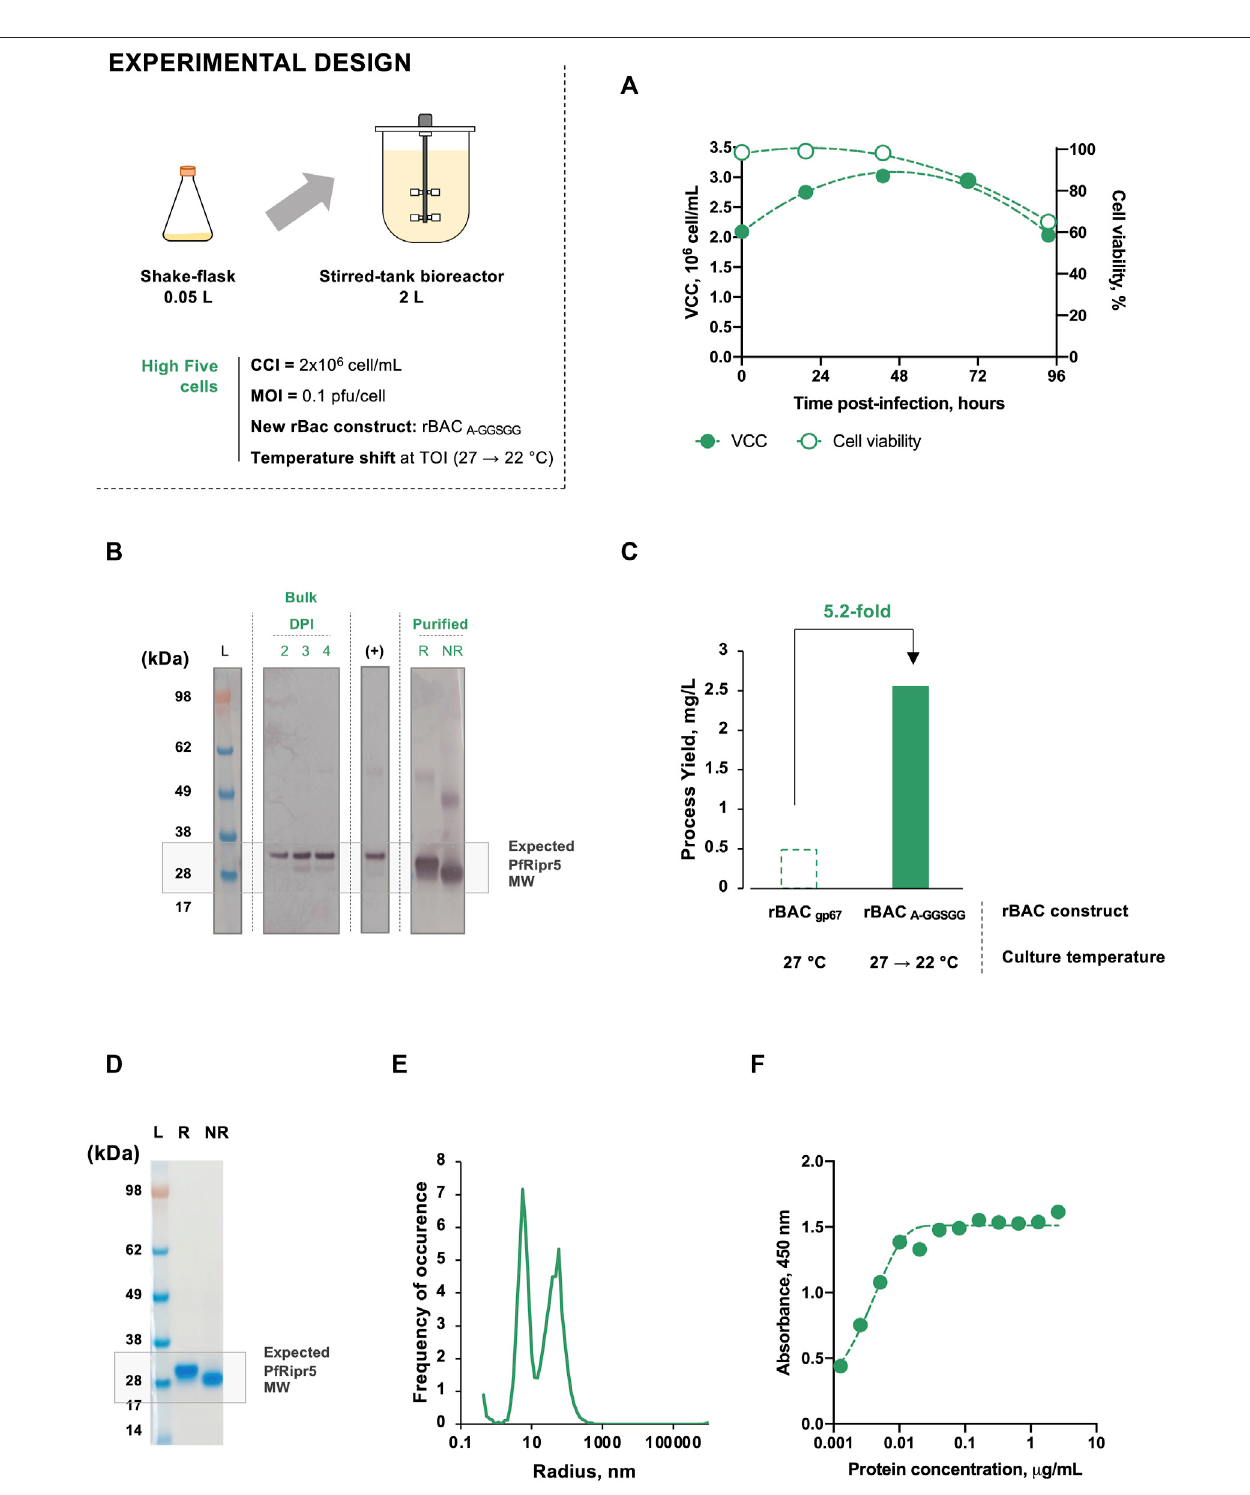
FIGURE 4 | Production of PfRipr5 at 2 L STB scale using the optimized production strategy (infection of insect High Five cells with rBAC A-GGSGG and culture temperature shift from 27 to 22 ° C at TOI). (A) Kinetics of cell growth and viability throughout infection. (B) Western blot identi fi cation of PfRipr5 in bulk and puri fi ed samples. (C) Production yield following puri fi cation. (D) SDS-PAGE of puri fi ed PfRipr5. (E) Size distribution pro fi le of puri fi ed PfRipr5 assessed by dynamic light scattering. (F) ELISAof puri fi ed PfRipr5 using an anti- P. falciparum PfRipr mouse mAb 29B11.For fi gure (A) , VCC denotes viablecell concentration. For fi gure (B) , DPI denotes day post-infection, (+) denotes the positive control (PfRipr5 produced by WGCFS). For fi gure (B) and fi gure (D) , L denotes pre-stained protein standard SeeBlue ® Plus2, R denotes reduced sample, and NR denotes non-reduced sample. Infection was performed using CCI = 2 × 10 6 cell/mL and MOI = 0.1 pfu/cell. Data are relative to one biological replicate ( n =